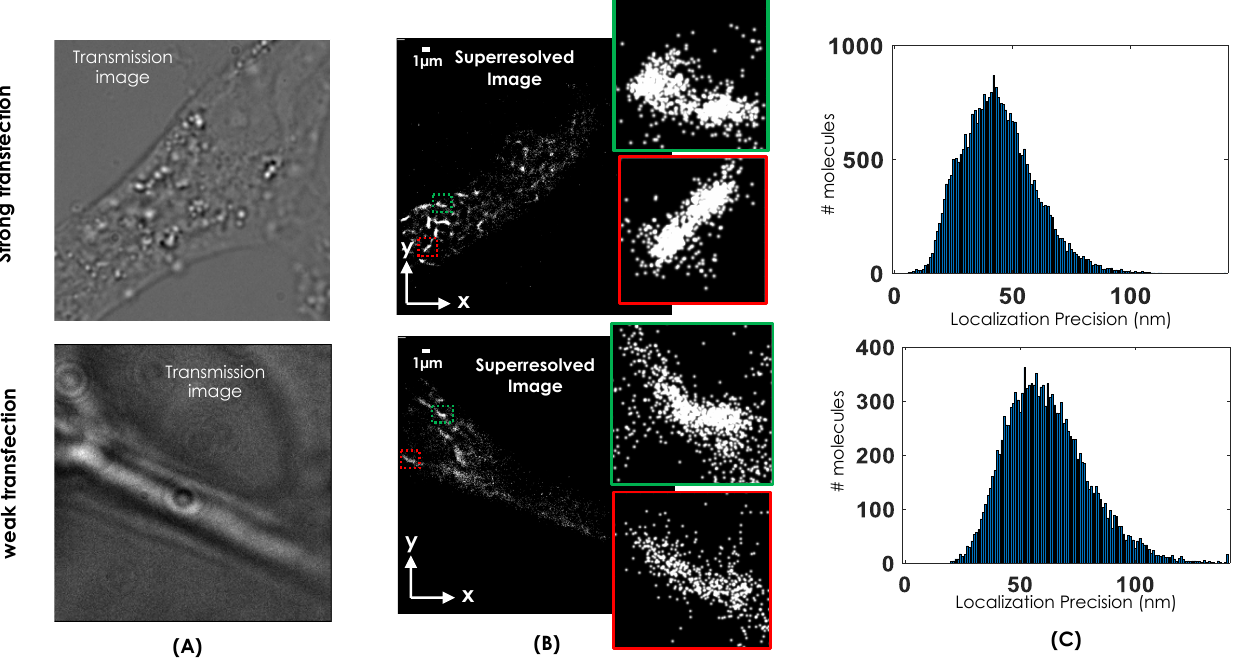
Figure 2. ( A ) Transmission image of the transfected cells chosen for study. ( B ) Reconstructed super- resolved images of a single NIH3T3 cell along with transmission images and enlarged clusters (red and green regions). ( C ) The localization plot of resolved single molecules for strong and weak transfected cell that show an average localization precision of 45 nm and 55 nm,